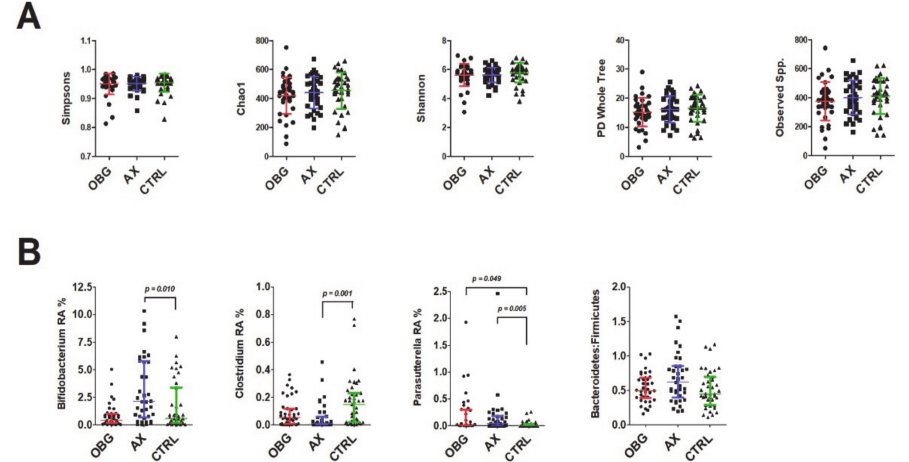
Figure 3. ( A ) α -diversity plots and ( B ) relative abundances (RA) of Bifidobacterium , Clostridium , Parasutterella and Bac- teroidetes:Firmicutes ratio in faecal microbiota after five weeks of oat β -glucan (OBG), arabinoxylan (AX) or control (CTRL) consumption. Values are presented as mean ± SD or median ± IQR and differences between intervention groups were tested with one-way ANOVA ( A ) or a Kruskal–Wallis test ( B ), respectively. p -values represent significant differences for the pairwise comparisons between OBG or AX compared to CTRL, tested by uncorrected Mann–Whitney U